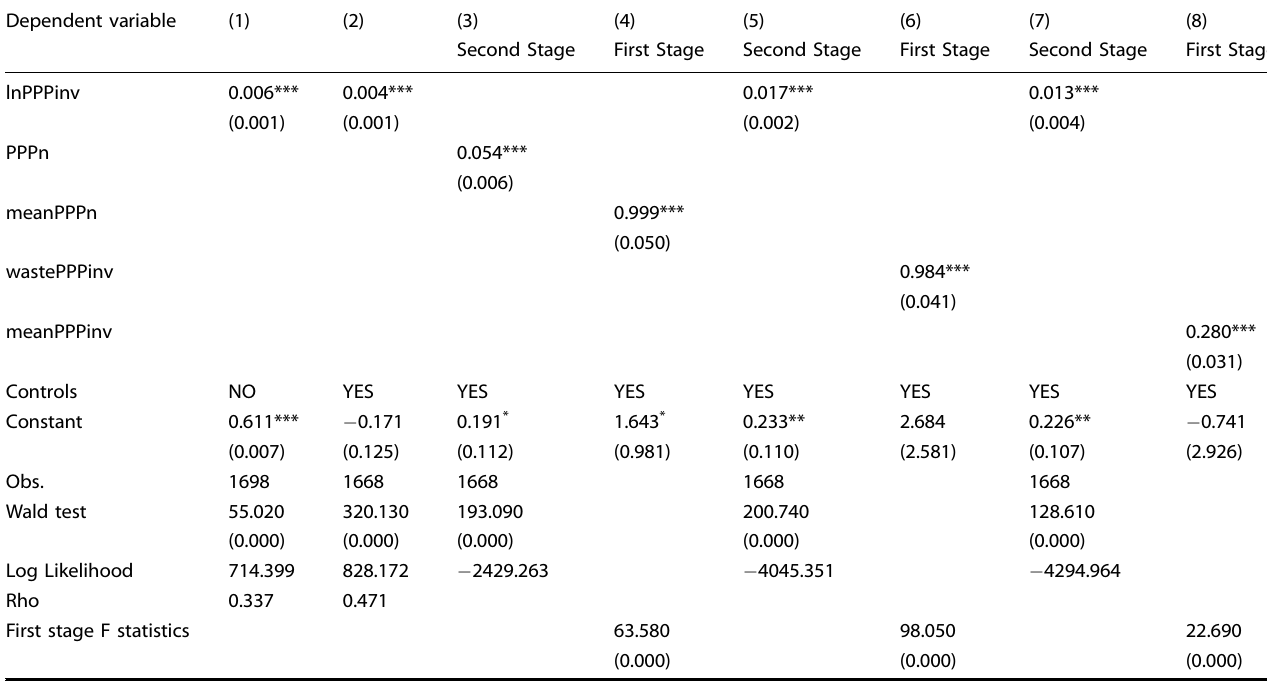
Table 2. Robustness check